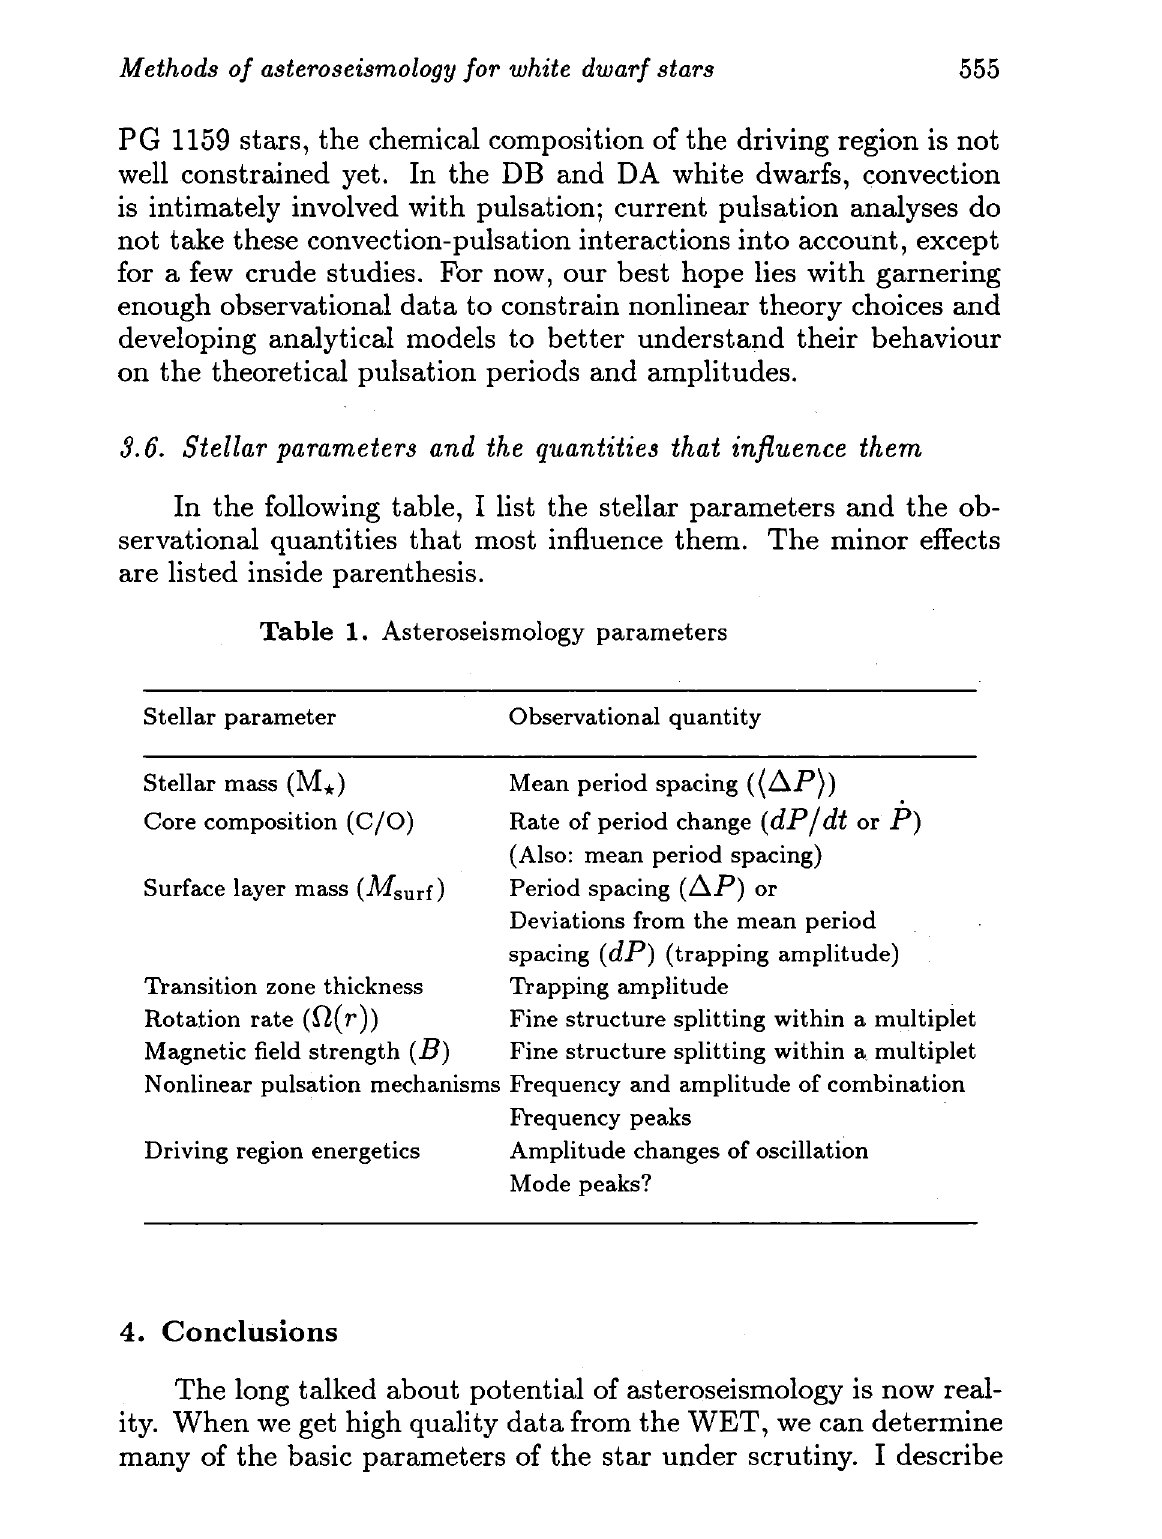
Table 1. Asteroseismology parameters Stellar